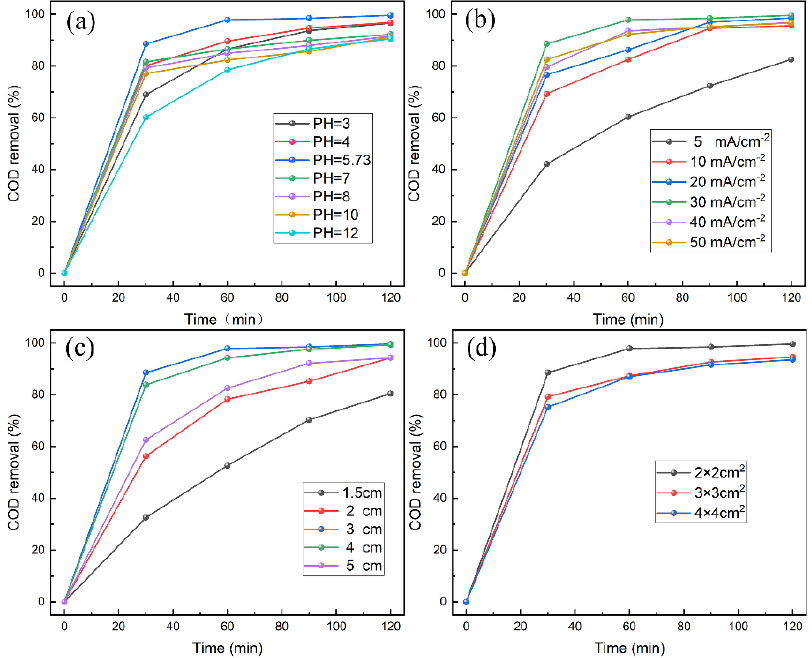
Figure 4. Effects of initial pH value ( a ), current density ( b ), pole plate spacing ( c ), and electrode area ( d ) on the COD removal of n-Fe 3 O 4 /ACF. ( d ) on the COD removal of n-Fe 3 O 4